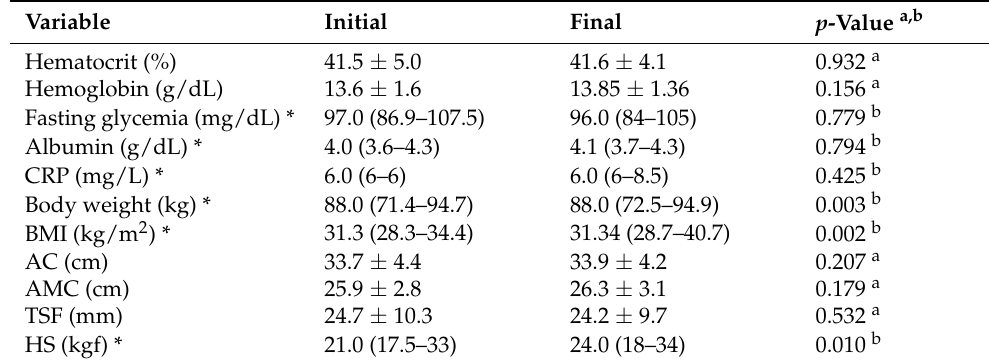
Table 4. Biochemical and body composition variables of patients with venous ulcers before and after nutritional